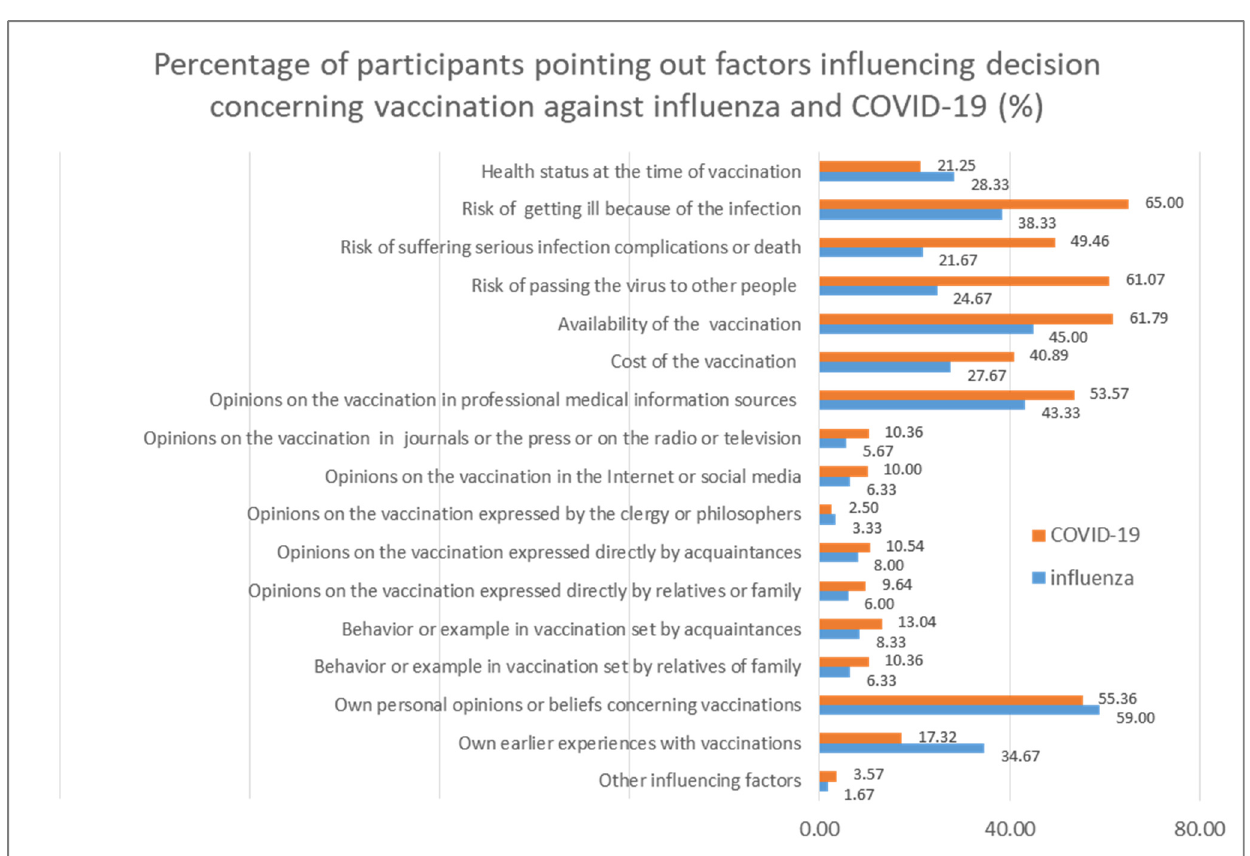
Figure 4. Percentage of participants pointing out factors influencing their decision concerning vaccination against influenza and COVID-19 (%).